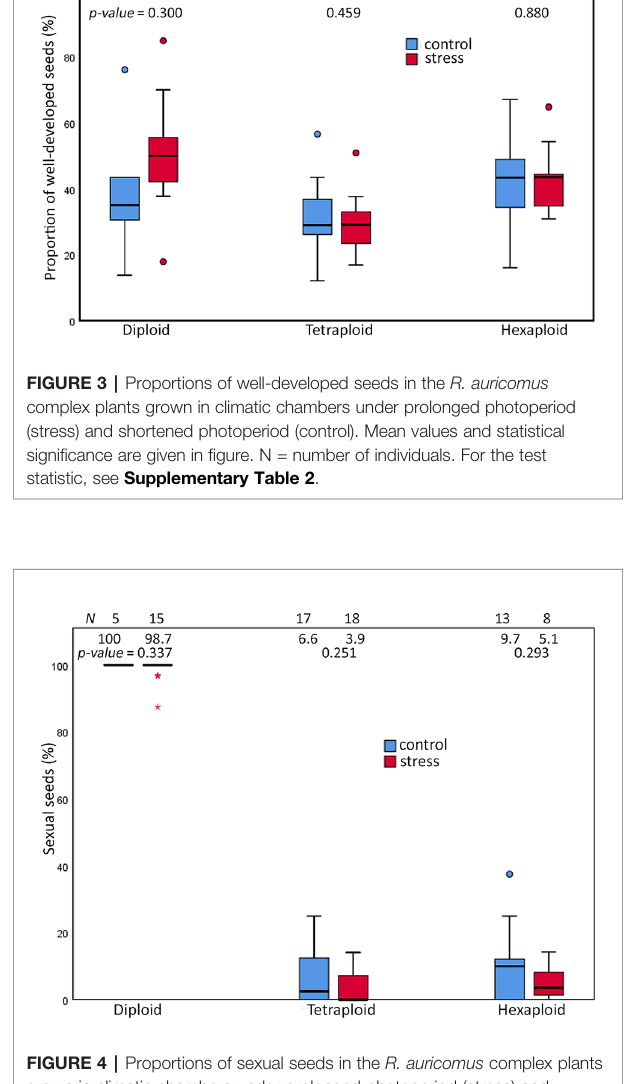
FIGURE 4 | Proportions of sexual seeds in the R. auricomus complex plants grown in climatic chambers under prolonged photoperiod (stress) and shortened photoperiod (control). Mean values and statistical signi fi cance are given in fi gure. N = number of individuals. For the test statistic, see Supplementary Table 2 .